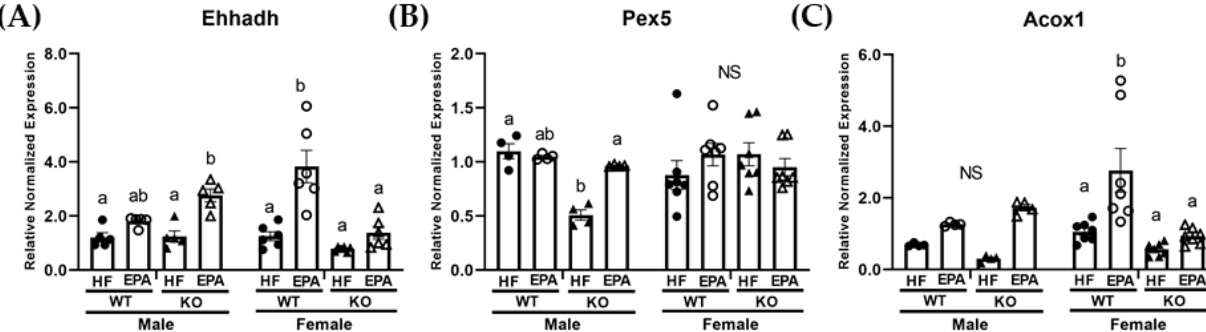
Figure 4. Sex-dependent effects on markers of hepatic peroxisomal fatty acid (FA) oxidation. mRNA level of ( A ) enoyl-CoA hydratase ( Ehhadh ), ( B ) peroxisomal biogenesis factor 5 ( Pex5 ) and ( C ) acox-acyl coA oxidase ( Acox1 ) in male and female WT and UCP1 KO groups fed HF diets and EPA supplemented HF diets. ( A – C ) Data are expressed as mean ± SEM, n = 4–6; means without a common letter (a, b) differ in each male or female group; means with any common letter (a or b vs. ab) are not different from each other. NS indicates no significant post ‐ hoc comparisons.